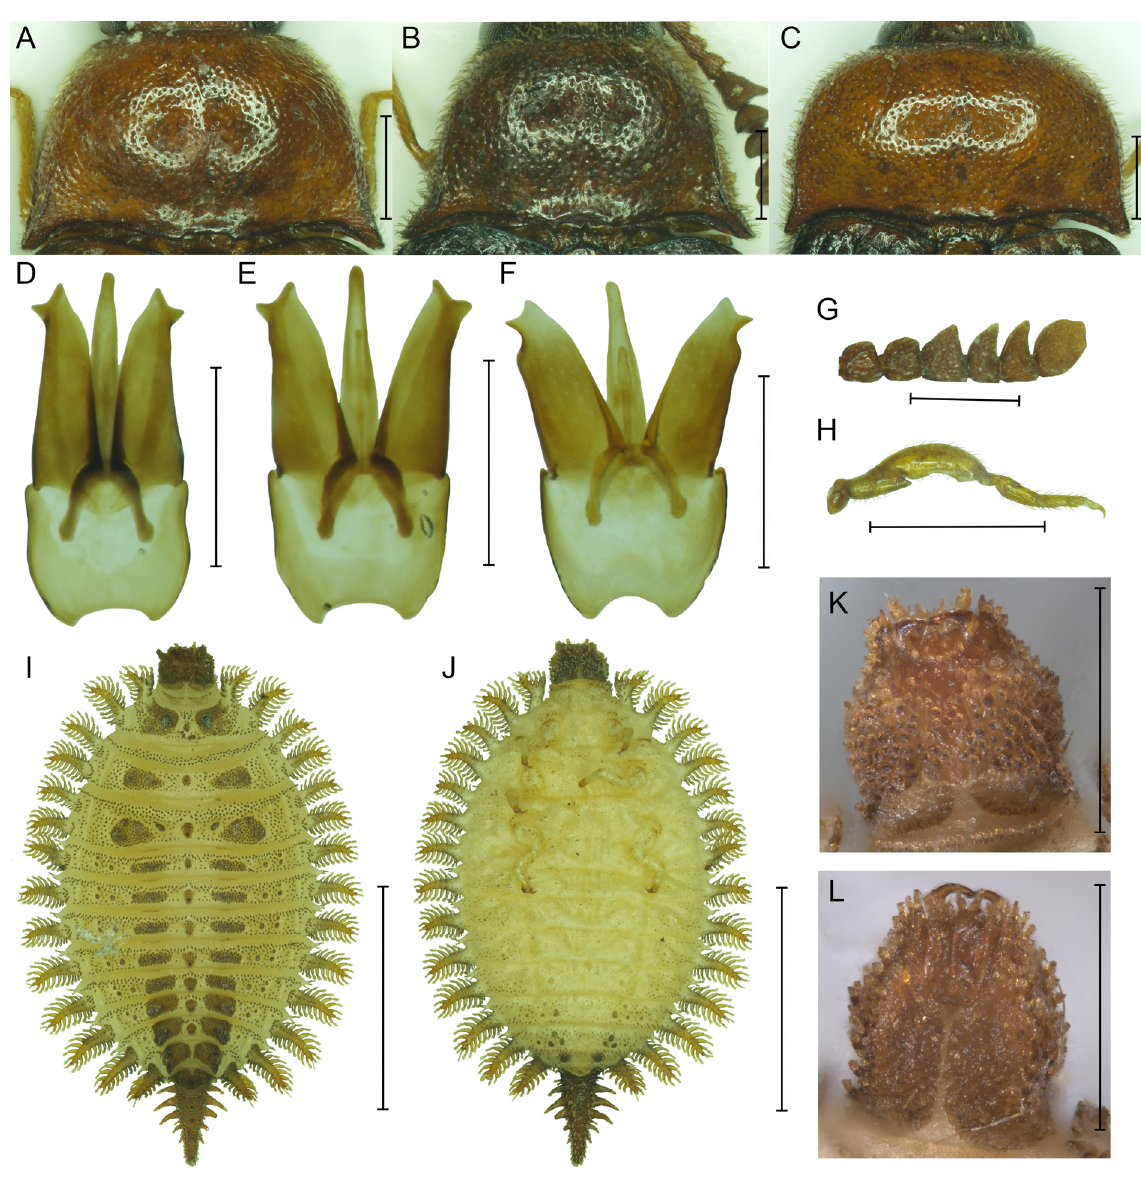
Fig. 2. A–C . Pronotum of Brachypsectra spp. A . ♂ of B. kadleci Hájek, 2010, holotype. B . ♂ of B. jaechi sp. nov., paratype. C . ♀ of Brachypsectra sp. from Cyprus. – D–F . Aedeagus of Brachypsectra spp. D . B. kadleci , Iran, Lorestan. E . B. kadleci , Iran, Geno. F . B. jaechi sp. nov., Turkey, Kemer. – G . ♀, apical part of antenna of Brachypsectra sp. from Cyprus. – H . ♀, apparently underdeveloped metathoracic leg of Brachypsectra sp. from Cyprus. – I–J . Habitus of Brachypsectra sp. from Cyprus, larva. I . Dorsal view. J . Ventral view. – K–L . Head of Brachypsectra sp. from Cyprus, larva (antennae removed). K . Dorsal view. L . Ventral view. Scale bars: A–H, K–L = 0.5 mm; I–J = 2